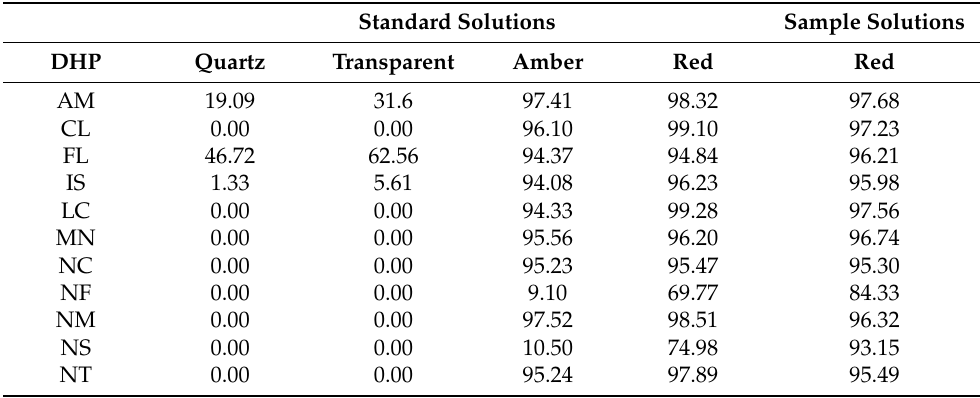
Table 2. Residue percentage of drug in hydroalcoholic and PEG–ethanol solutions protected by different glasses after 120 min of forced irradiation. Standard